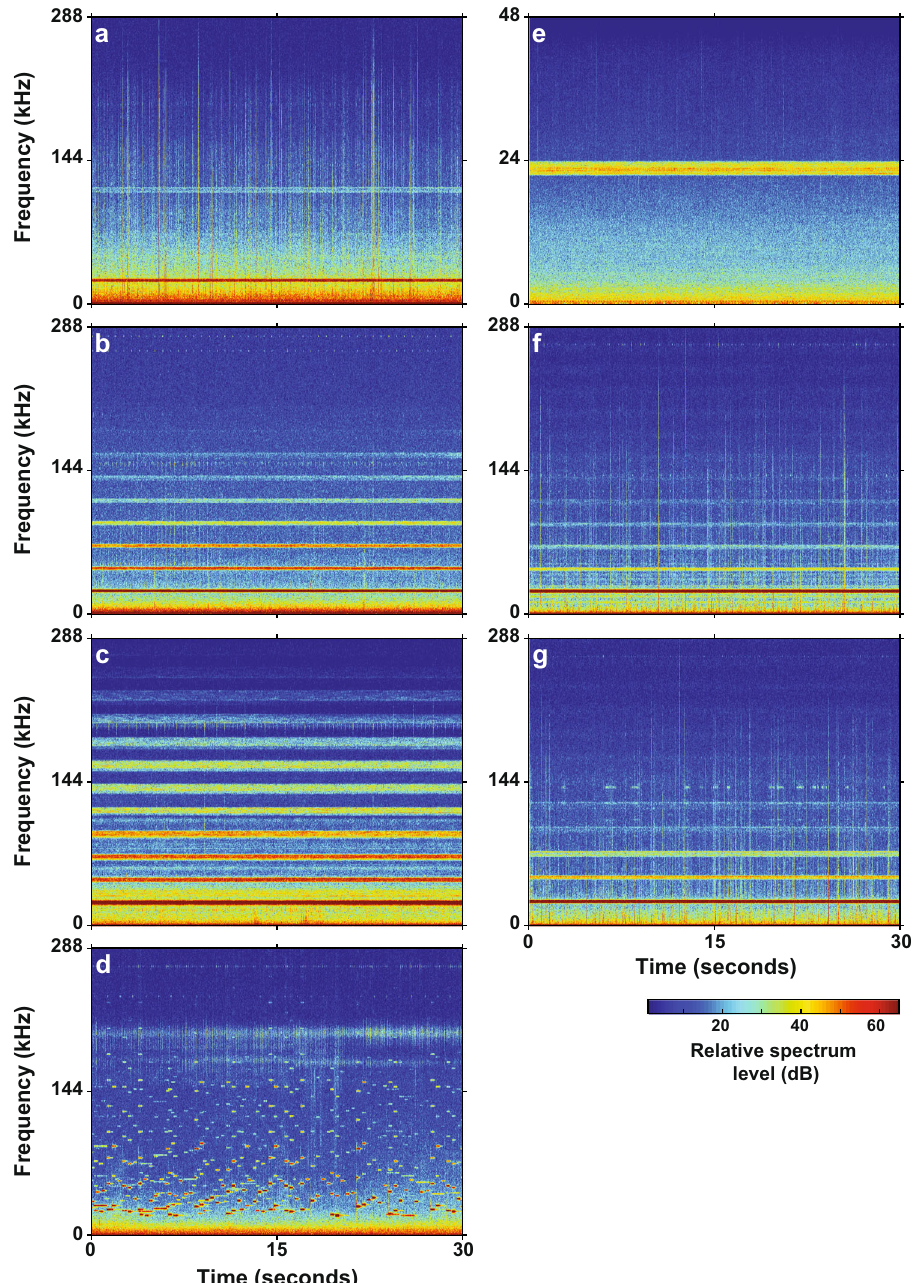
Fig. 6 Cruise ships. Spectrograms of ultrasonic antifouling signals recorded from seven individual cruise ships from fi ve different cruise lines, including the vessels a Koningsdam , b Carnival Miracle , c Oceania Regatta , d Navigator of the Seas , e Royal Princess , f Grand Princess , and g Majestic Princess . The recorder used for the Royal Princess had a 96 kHz sampling rate, and the recorders used for all other vessels had a 576 kHz sampling Computation of soundscape metrics . Soundscape metrics of the full HARP time series were computed using the MATLAB-based Triton “ Remora ” (a type of plug- in) Soundscape Metrics (https://github.com/MarineBioAcousticsRC/Triton/tree/ master/Remoras/Soundscape-Metrics). Periods of 15-s disk-write noise, occurring on a repeating cycle every 75s, were omitted from analysis. The broadband (0 – 100kHz) acoustic data were processed to compute power spectral density (PSD) using Welch ’ s method within MATLAB (FFT length = 200,000 points, Hann window length = 200,000, FFT overlap = 0%), resulting in mean-square pressure amplitude (µPa 2 ) at 1-Hz, 1-s resolution. For every 1-Hz frequency band, PSD levels per 1-min were calculated as the median of mean-square pressure amplitude (µPa 2 ) over no less than 30 s for that minute. PSD levels were then converted to decibels (dB re: 1µPa 2 /Hz).